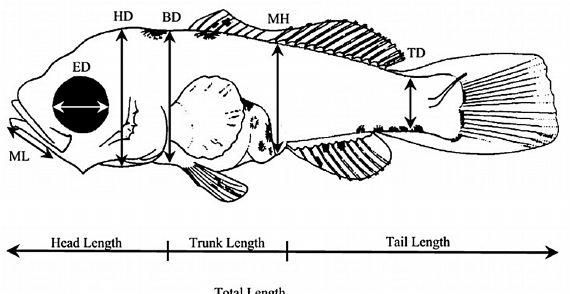
F IG . 1. – Morphometric characters measured in the spotted sand bass larvae. BD, body depth; ED, eye diameter; HD, head depth; MH, musculature height; ML, mouth length; TD, tail